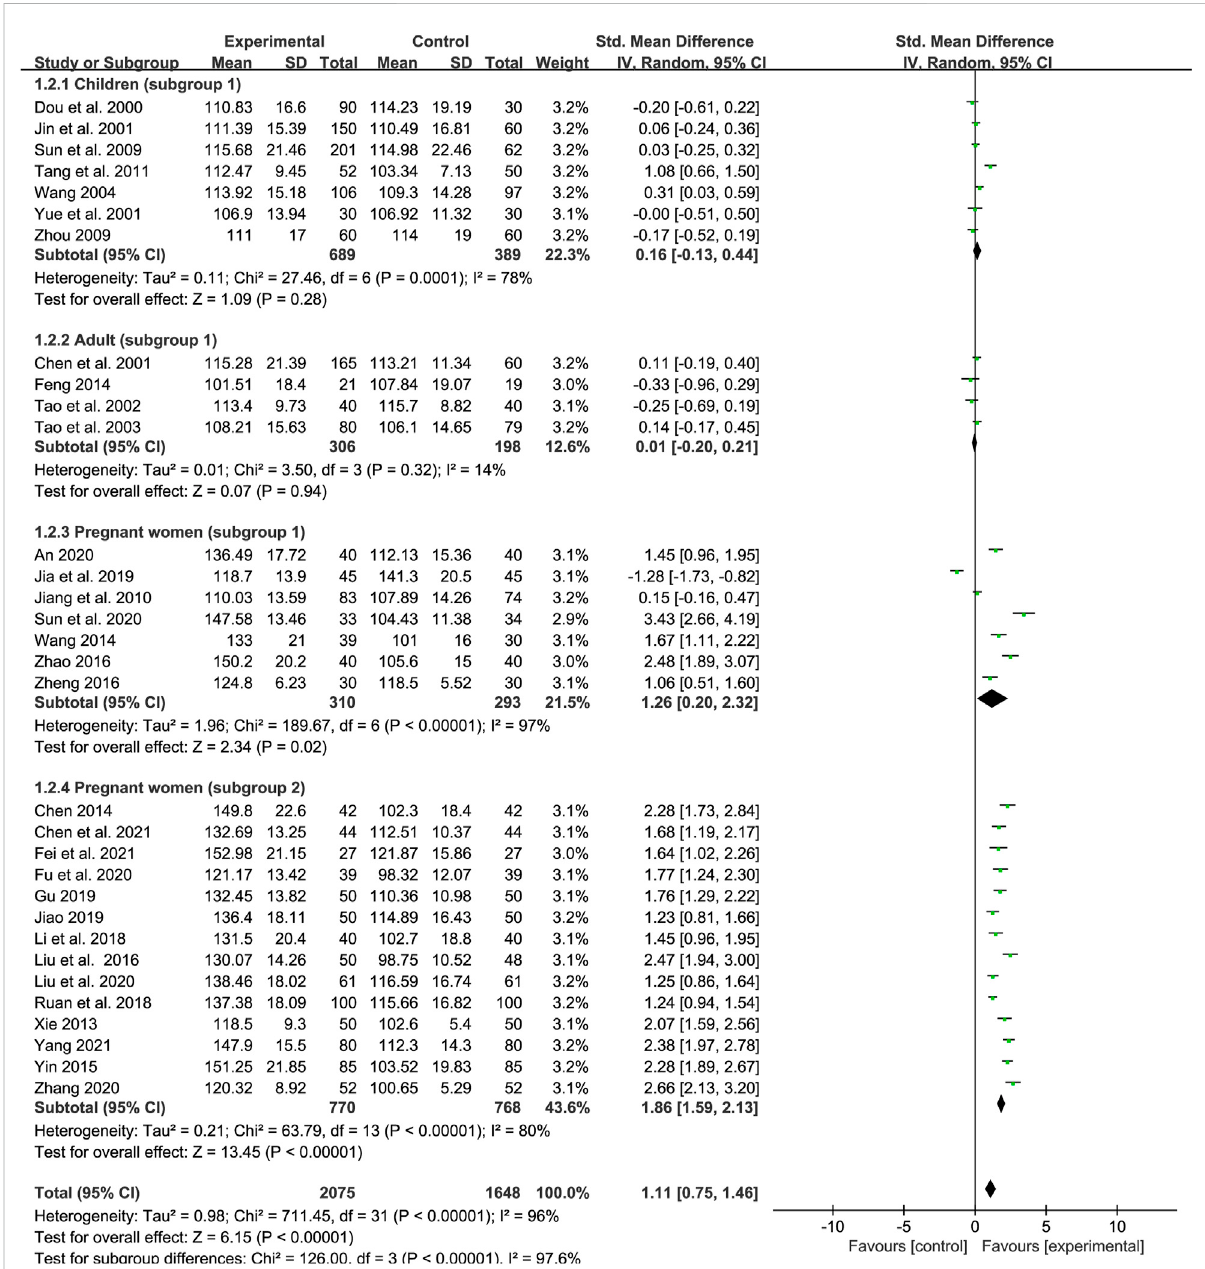
FIGURE 4 The forest plot assessing the effect of SXN on Hb